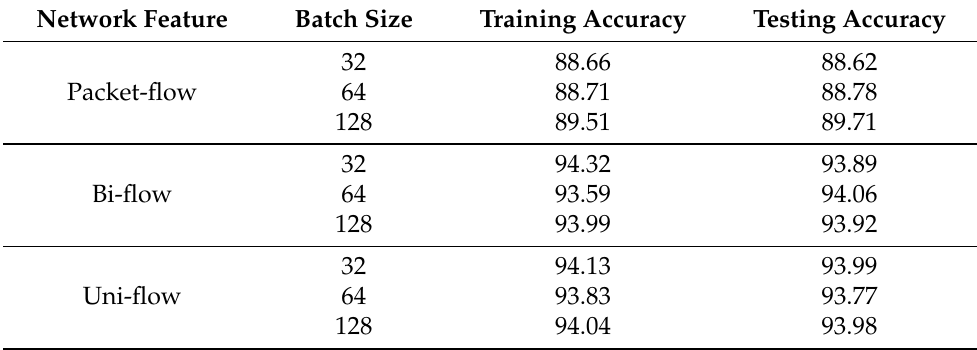
Table 7. Multi-class attacks classification with sigmoid activation function on output